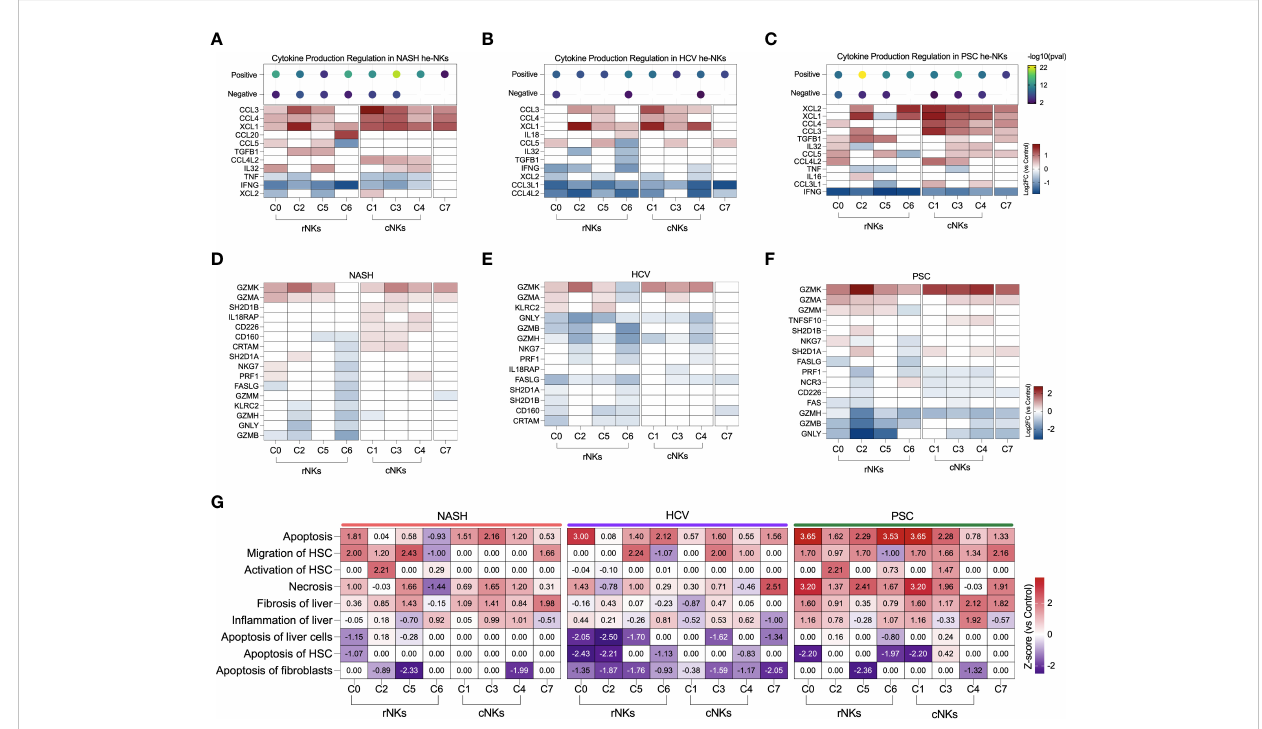
FIGURE 7 Transcriptomic analysis of NK cell clusters effector functions in end-stage liver diseases. (A – C) Top: Enrichment scores for cytokine production regulation. Bottom, main cytokines expressed by NK cells. NASH (A) , HCV (B) , and PSC (C) . (D – F) Main genes related to cytotoxicity expressed by NK cells in. NASH (D) , HCV (E) , and PSC (F) . (G) Heatmap displaying the main biological processes related to in fl ammation and fi